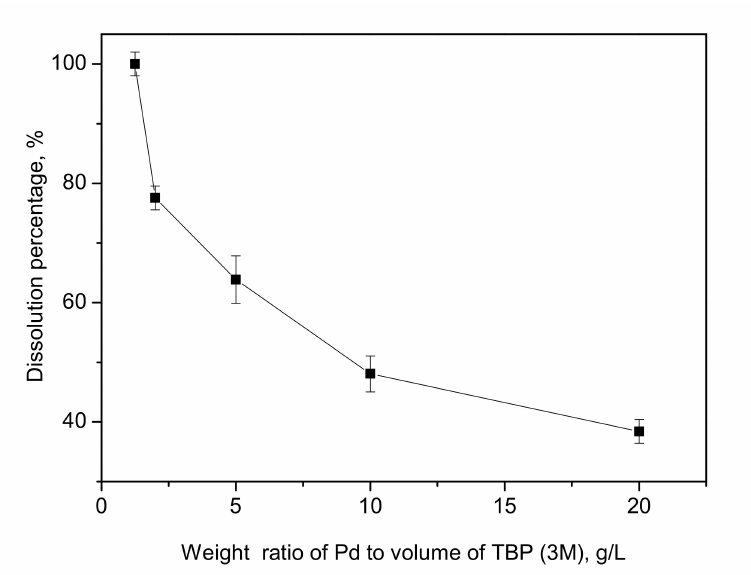
Figure 3. Effect of the weight ratio of Pd to TBP (3 M) on the dissolution of Pd. Conditions: TBP = 3 M; diluent: kerosene; Pd/HCl ratio = 10 g/L; Pd/H 2 O 2 ratio = 10 g/L; 60 min, 60 ◦